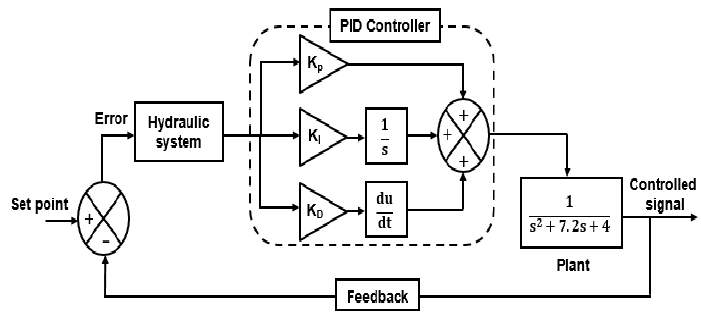
Figure 3. PID control algorithm for pressure control without considering viscosity [42].